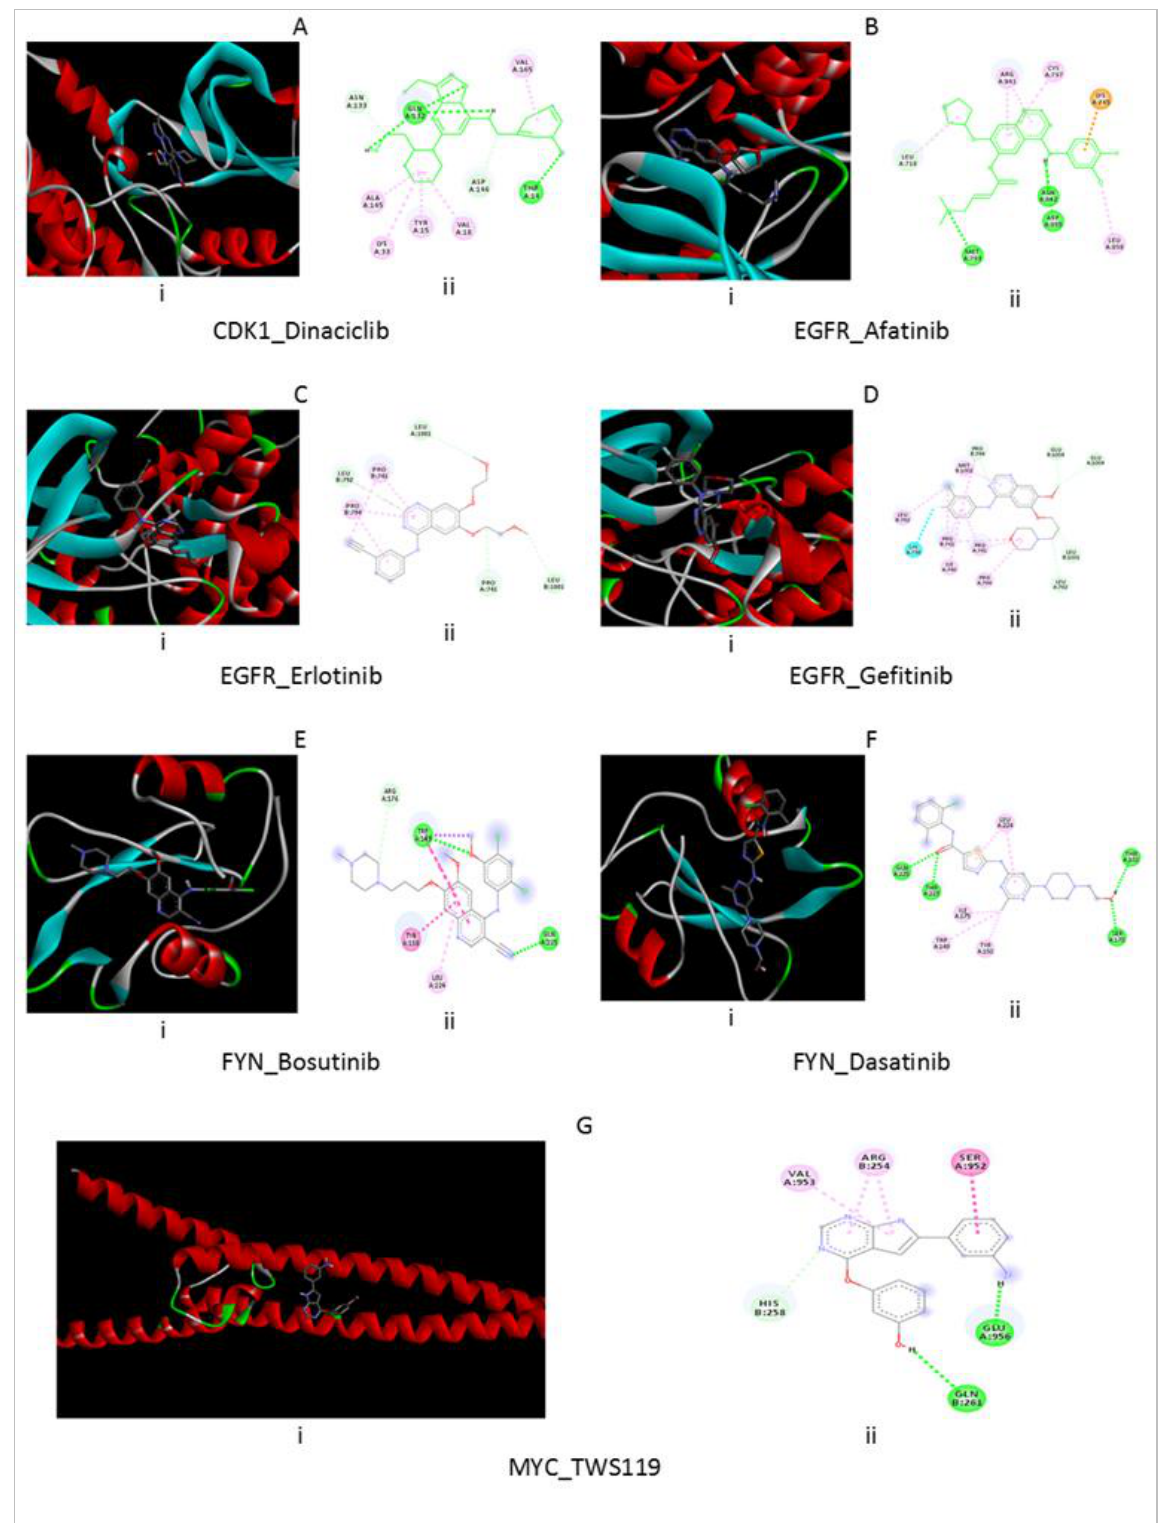
Figure 9. The molecular docking poses for the selected repurposed drugs and potential target proteins. The figure showed the best docking pose between protein and drug, like in ( A ) between CDK1-Dinaciclib; in ( B ) between EGFR-Afatinib; in ( C ) between EGFR-Erlotinib; in ( D ) between EGFR-Gefitinib; in ( E ) between FYN-Bosutinib; in ( F ) between FYN-Dasatinib and in ( G ) between MYC-TWS119 respectively.